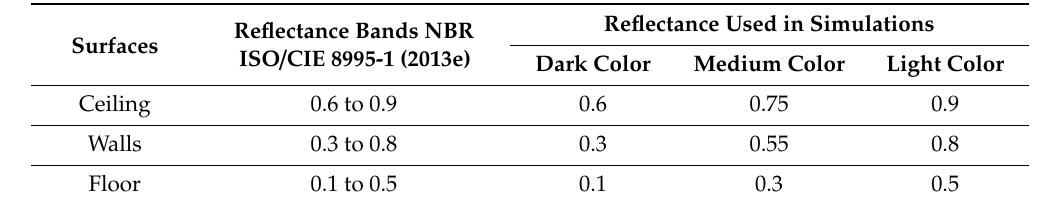
Table 18. Reflectance values used in numerical simulations. Surfaces